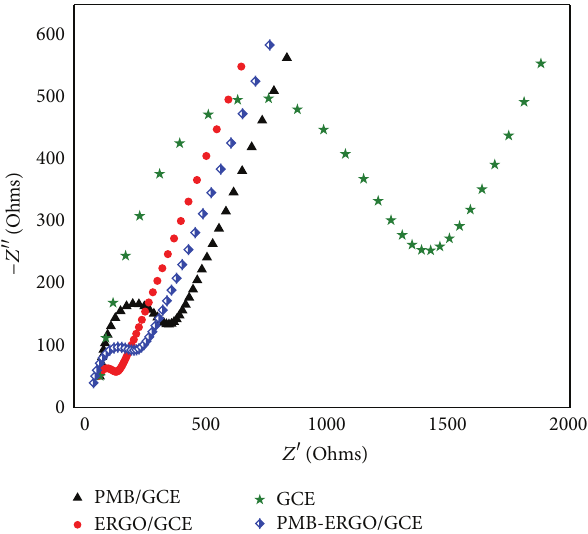
Figure 5: CVs of bare GCE, PMB/GCE, ERGO/GCE, and PMB- ERGO/GCE in the mixture solution of UA and Xa and PBS (pH 3.0) at a scan rate of 0.14 V ⋅ s −1 with quiet time for 2